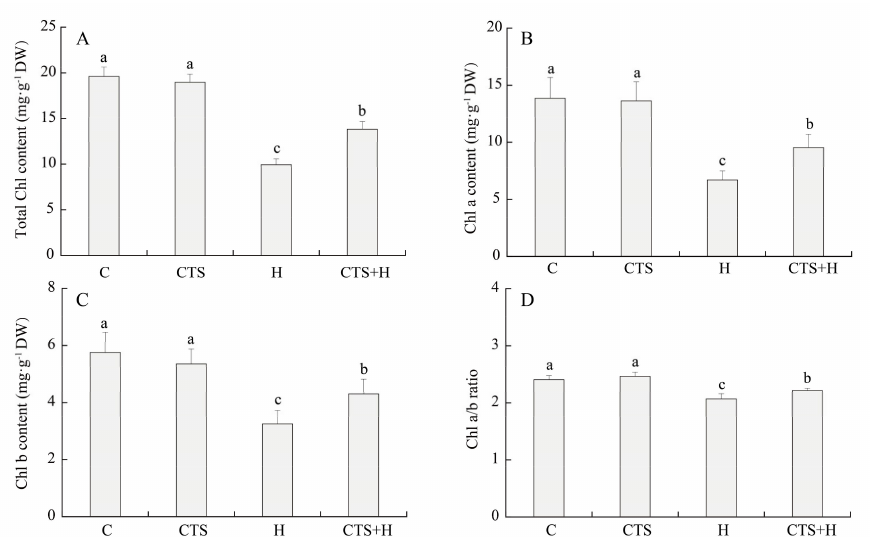
Figure 3. Effect of chitosan on ( A ) total chlorophyll (Chl) content, ( B ) Chl a content, ( C ) Chl b content, and ( D ) Chl a/b ratio under control and heat stress conditions. Vertical bars above columns indicate ± standard error (SE) of means ( n = 4) and different letters above columns indicate significant differences among treatments ( p ≤ 0.05).